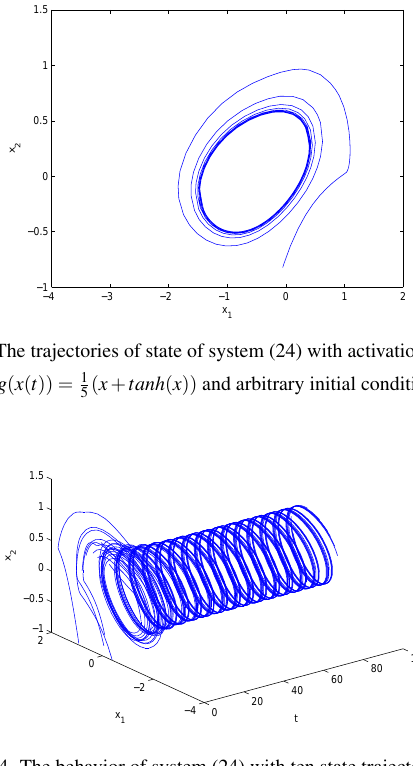
Fig.4. The behavior of system (24) with ten state trajectories of random